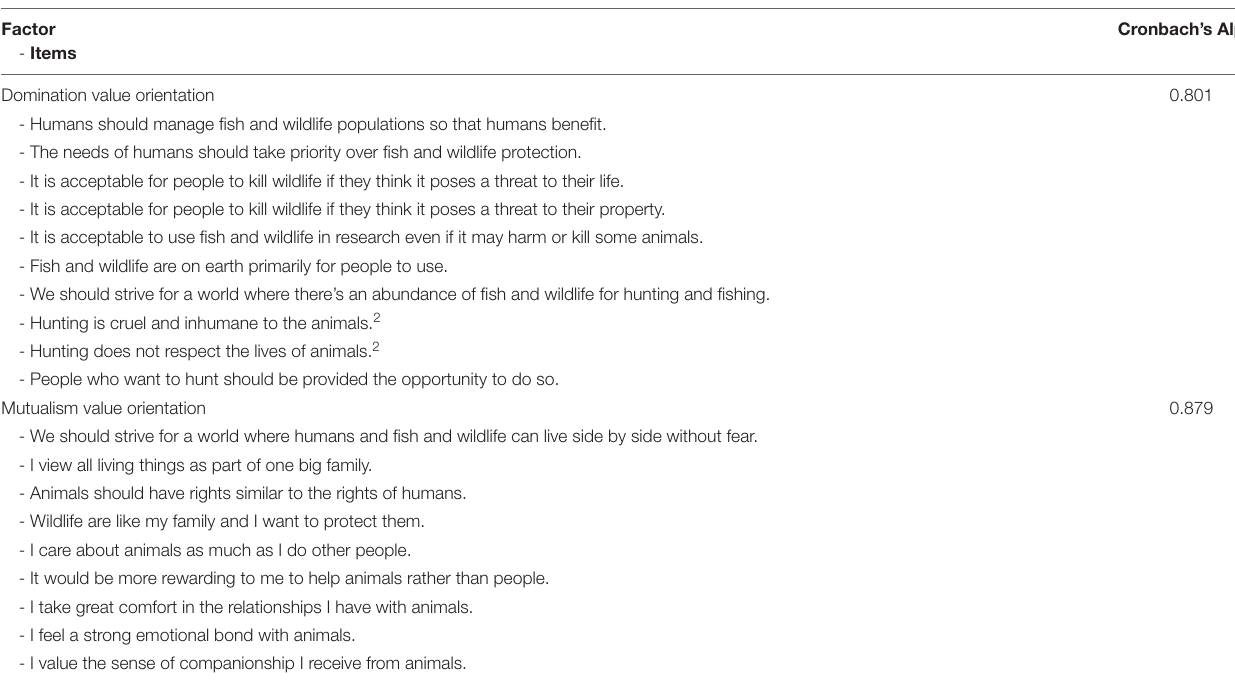
TABLE A1 | Wildlife value orientation survey items adapted from Teel and Manfredo (2009) 1